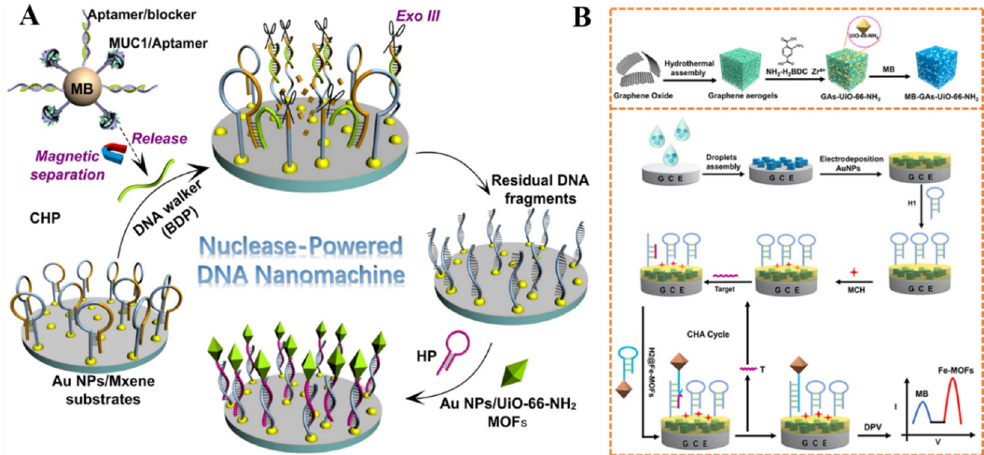
Figure 13. ( A ) Schematic illustration of AuNPs/UiO-66-NH 2 MOFs-based biosensor for protein biomarkers (MUC1) analysis with the DNA nanomachines powered by Exo III with cycle signal amplification. Reprinted with permission from Ref. [245]. Copyright 2022, Elsevier. ( B ) Schematic illustration of the MB − GA − UiO-66-NH 2 synthesis procedure and the principle of a ratiometric electrochemical biosensor for the detection of miRNA-155. Reprinted with permission from Ref. [246]. Copyright 2022, American Chemical